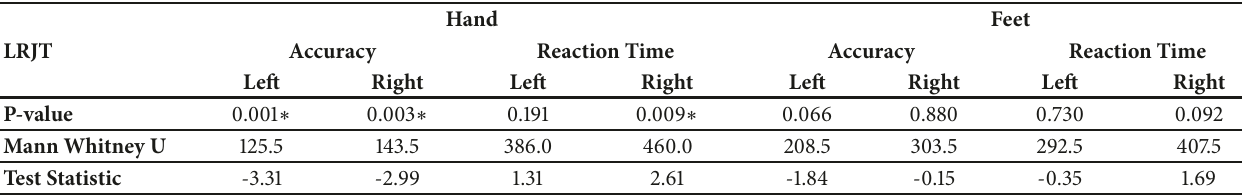
Table 6: Nonparametric test results for Left Right Judgement Task performance accuracy and reaction time in participants who were taking pain medication and not taking pain medication on the day of the